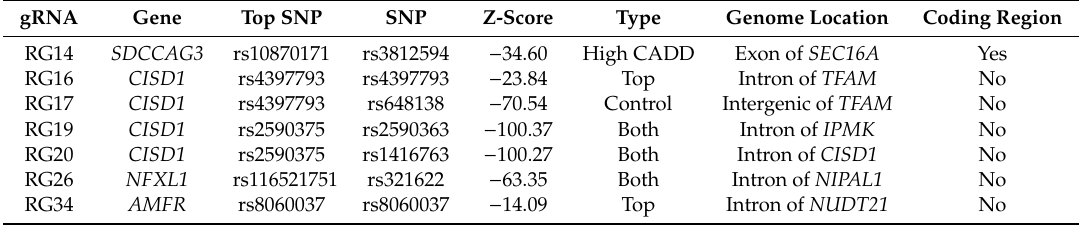
Table 1. Guide RNAs and target SNPs. Each guide RNA targets on the “SNP”, which is within a credible set of “gene”. The e ff ect size (z-score) of each SNP from the eQTLGen browser [26]. “Top SNP” is the SNP with the lowest p -value in the credible set. Several criteria were used to predict the likelihood of candidate SNPs: “High CADD” is the SNP with high CADD (Combined Annotation Dependent Depletion) score that has a high level of deleteriousness of its variants, including Indel variants; “Top” is the SNP with the strongest signal of eQTL-mapping; “Both” is the SNP with both high CADD score and low evolutionary probabilities (EP) of the minor allele; “Control” is the negative control SNP in high linkage disequilibrium (LD) with the top SNP but low CADD and normal EP. gRNA Gene Top